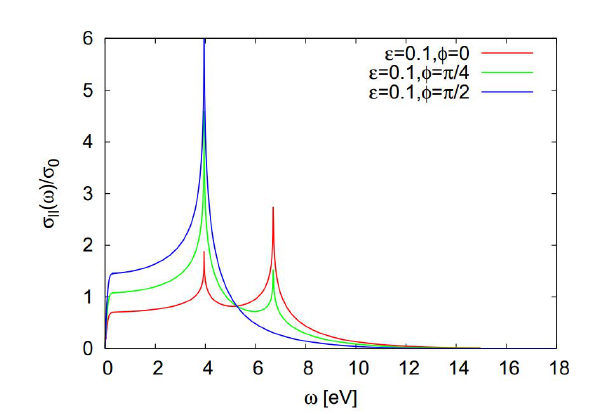
Figure 5. Plotting of longitudinal-optical conductivity when frequency ω > 0. Other parameters are kept as µ = 0 and k B T = 0.025 eV. The applied strain angle is 0. In addition, the strain modulus increases from left to right and top to bottom. ( a ) at strain modulus E = 0, the optical conductivity exhibits its maximum limit in the applied field angle; ( b ) the optical conductivity started splitting when strain modulus becomes non-zero; here, the strain modulus is considered as, E = 0.075; ( c ) increased optical conductivity with the increased strain modulus; here, the strain modulus is E = 0.175; ( d ) optical conductivity at strain modulus E = 0.275. Reprinted with permission from [38]. Copyright (2010) American Physical Society.